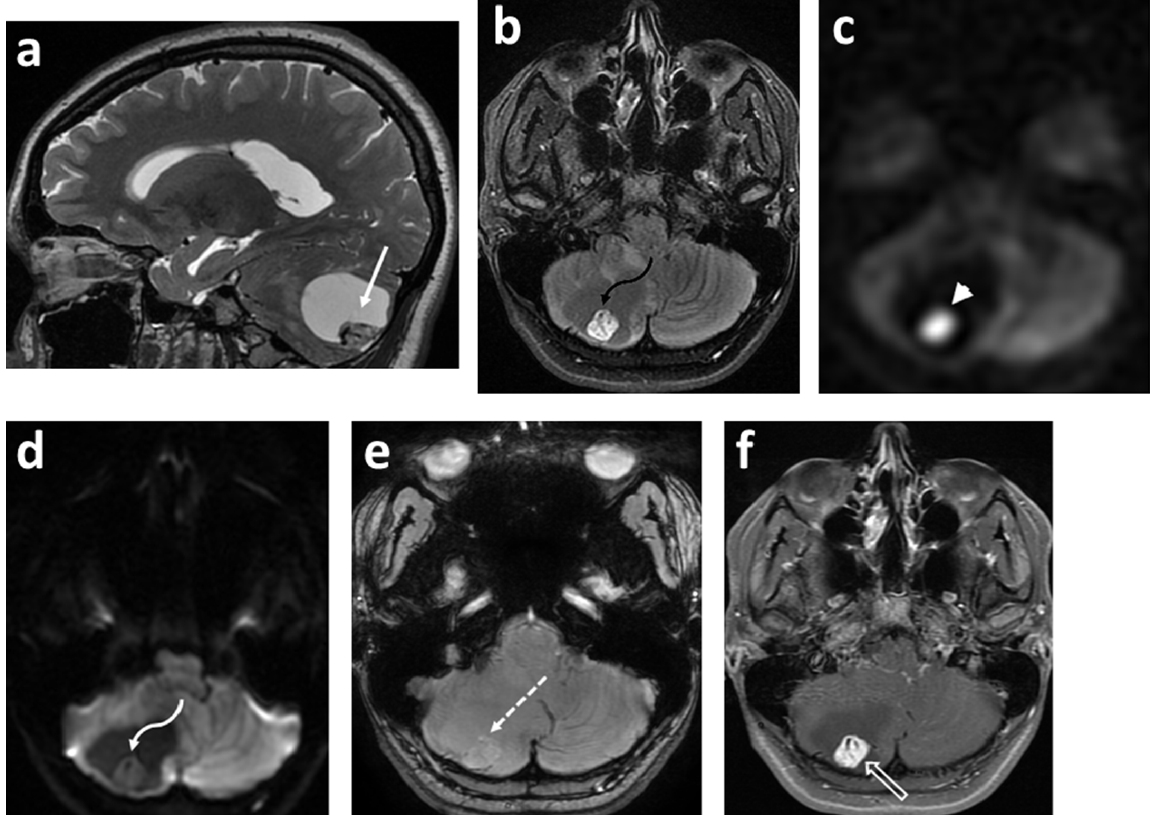
Figure 4. Sixteen-year-old female presented with headaches awakening her from sleep. Sagittal T2 ( a ); axial FLAIR ( b ); axial ASL-PWI ( c ); axial DWI ( d ); axial SWAN ( e ); and axial T1 fat saturated post contrast ( f ) images. There is a large cystic lesion within the right cerebellar hemisphere (solid white arrow) with a solid component within its posterior and inferior aspect (curved black arrow). The solid component of the tumor is hyperintense on T2/FLAIR images with multiple prominent flow voids indicating a highly vascular tumor. There is marked increased perfusion (arrowhead) of the solid component without associated restricted diffusion (curved white arrow). There is no calcification or hemorrhage within the solid component (dashed arrow), with the solid component demonstrating intense enhancement (open arrow) on the post-contrast image. Features are highly specific for hemangioblastoma (pathology proven). Author’s institutional human ethics committee/institutional review board guidelines were followed for anonymized